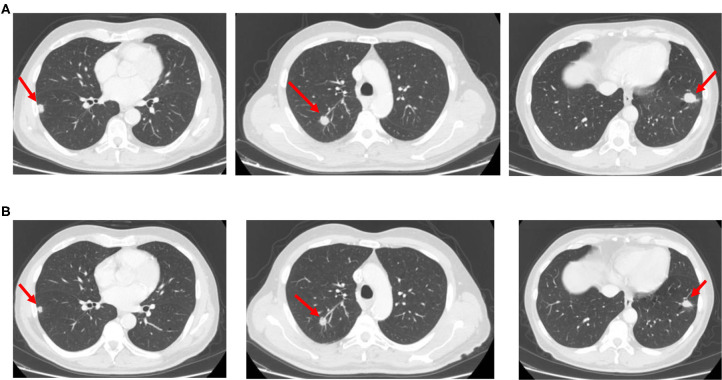
CT scan images showing bilateral lung metastases relapsed after first-line chemotherapy (A) and re-evaluated after aflibercept/chemotherapy re-introduction (B).